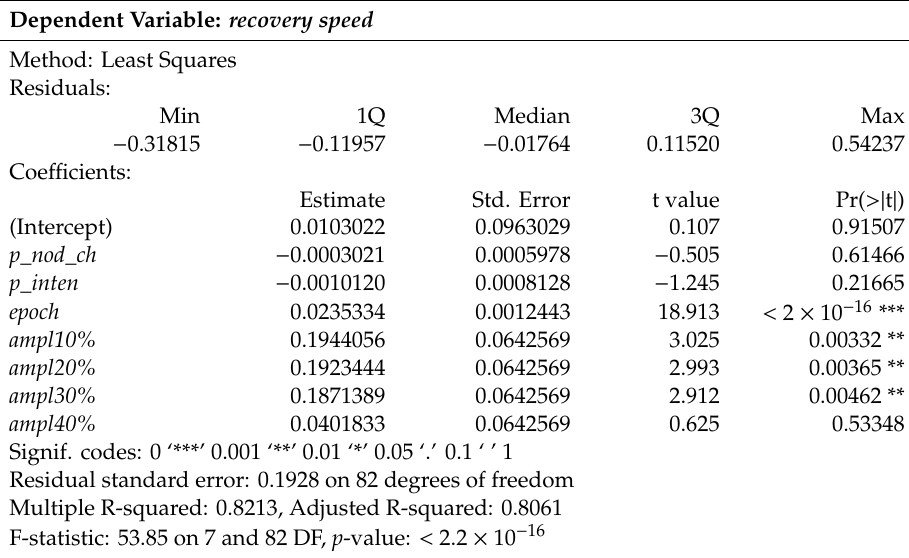
Table 3. Regression model for recovery speed , instance d2103